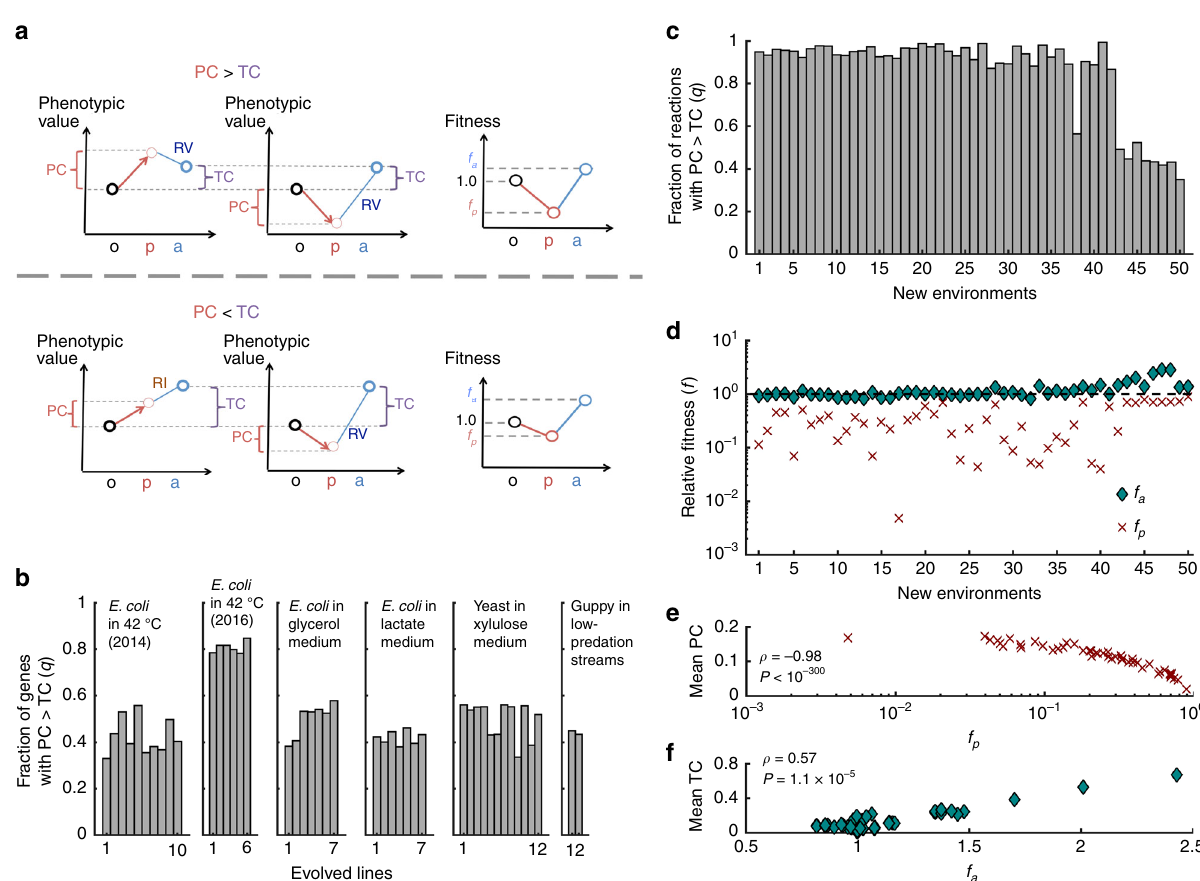
Fig. 3 Cause of the preponderance of phenotypic reversion in adaptation. a Diagram illustrating the model. The upper part shows that if the plastic change (PC) is greater than the total change (TC), the genetic change (GC) must reverse the PC (the left and middle diagrams). One reason for PC > TC is that the fi tness difference between organisms at stages o and p is greater than that between stages o and a (the right diagram). The lower part shows that if PC < TC, the GC either reinforces or reverses the PC (the left and middle diagrams). This may occur if the fi tness difference between organisms at stages o and p is smaller than that between o and a (the right diagram) or if the phenotype is unassociated with fi tness. b Fraction of genes showing expression PC > TC during each of 44 experimental evolutionary adaptations. c Fraction of reactions showing fl ux PC > TC during each of the E. coli metabolic adaptations from the glucose environment to the 50 new environments. d Fitness at stage p and that at stage a, relative to that at stage o, predicted by metabolic network analysis, for each of the 50 adaptations in c . The dotted line shows the fi tness at stage o. e Mean PC across all fl uxes negatively correlates with the relative fi tness at stage p ( f fl uxes positively correlates with the relative fi tness at stage a ( f p ) among the 50 adaptations in c . f Mean TC across all a ) among the